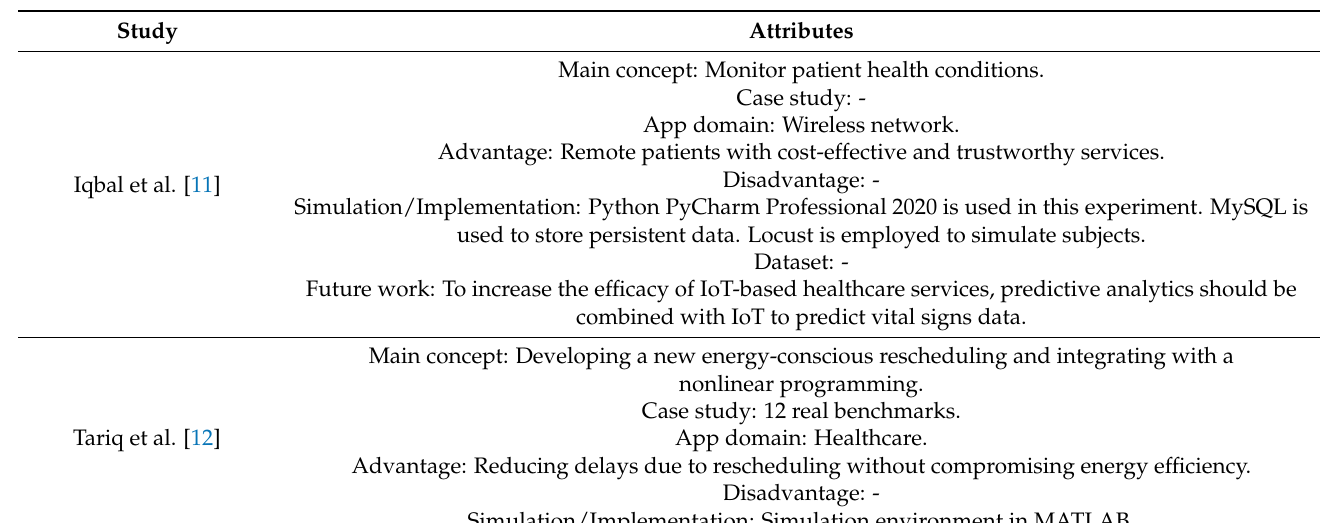
Table 18. Categorizing the state-of-the-art in health monitoring